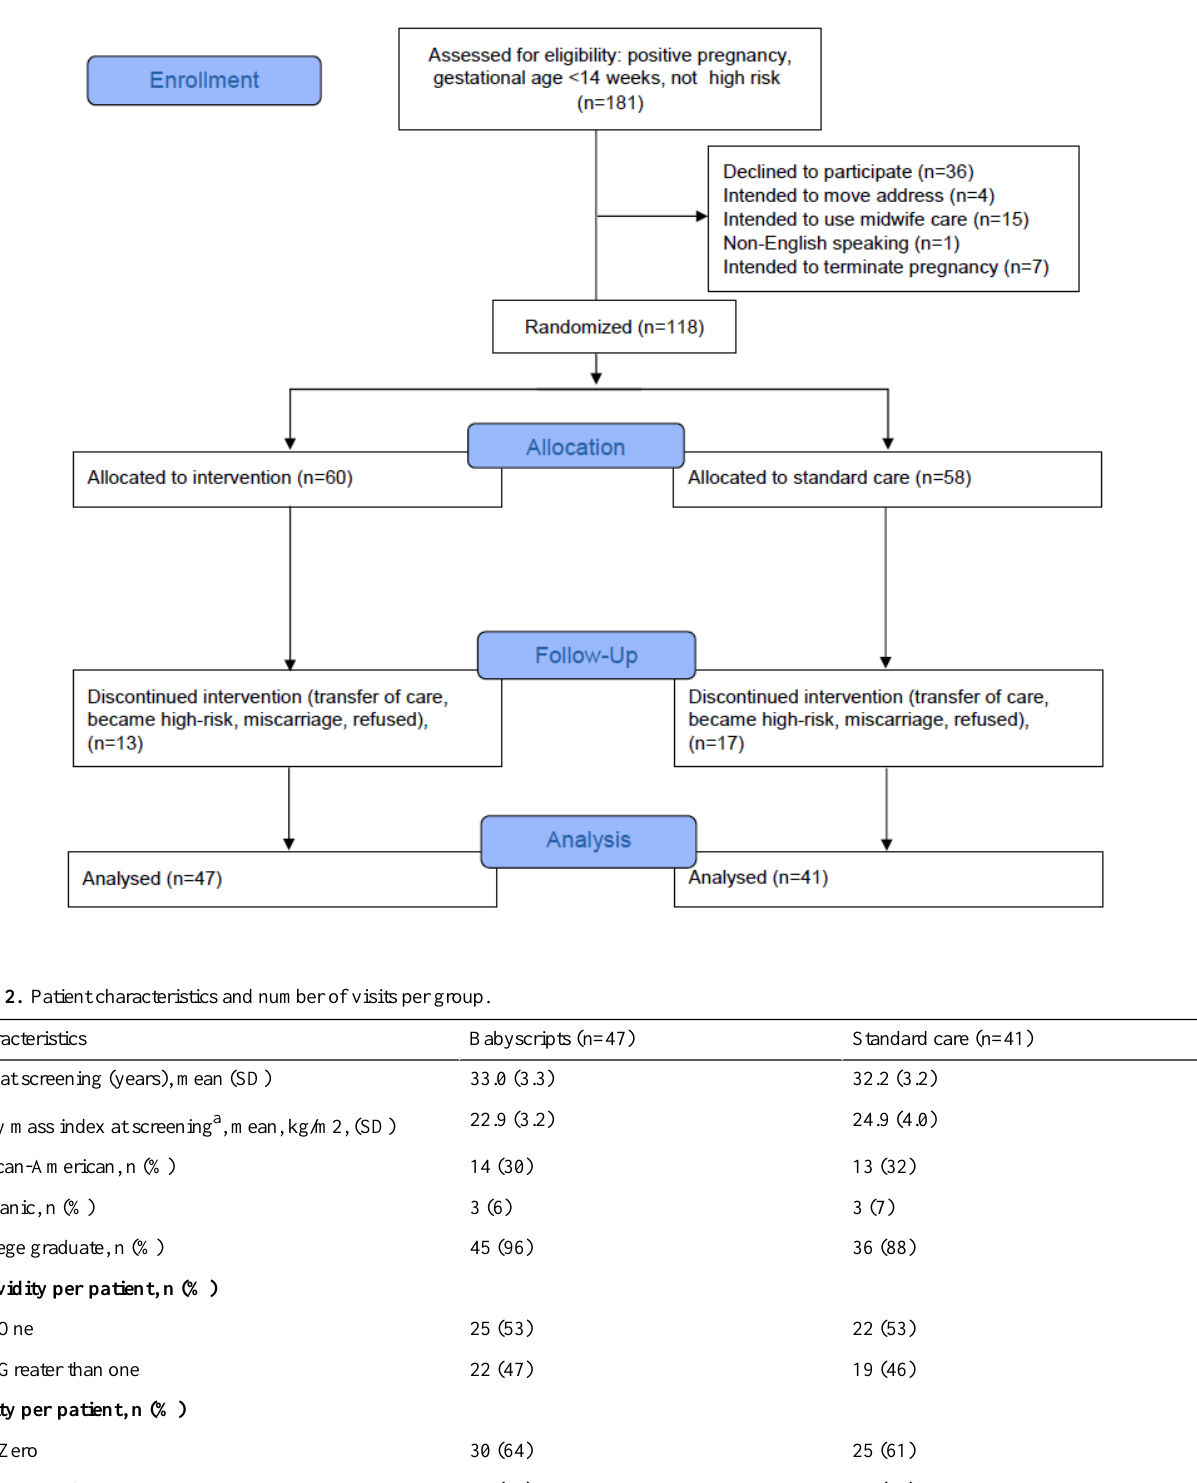
Figure 1. CONSORT flow diagram.